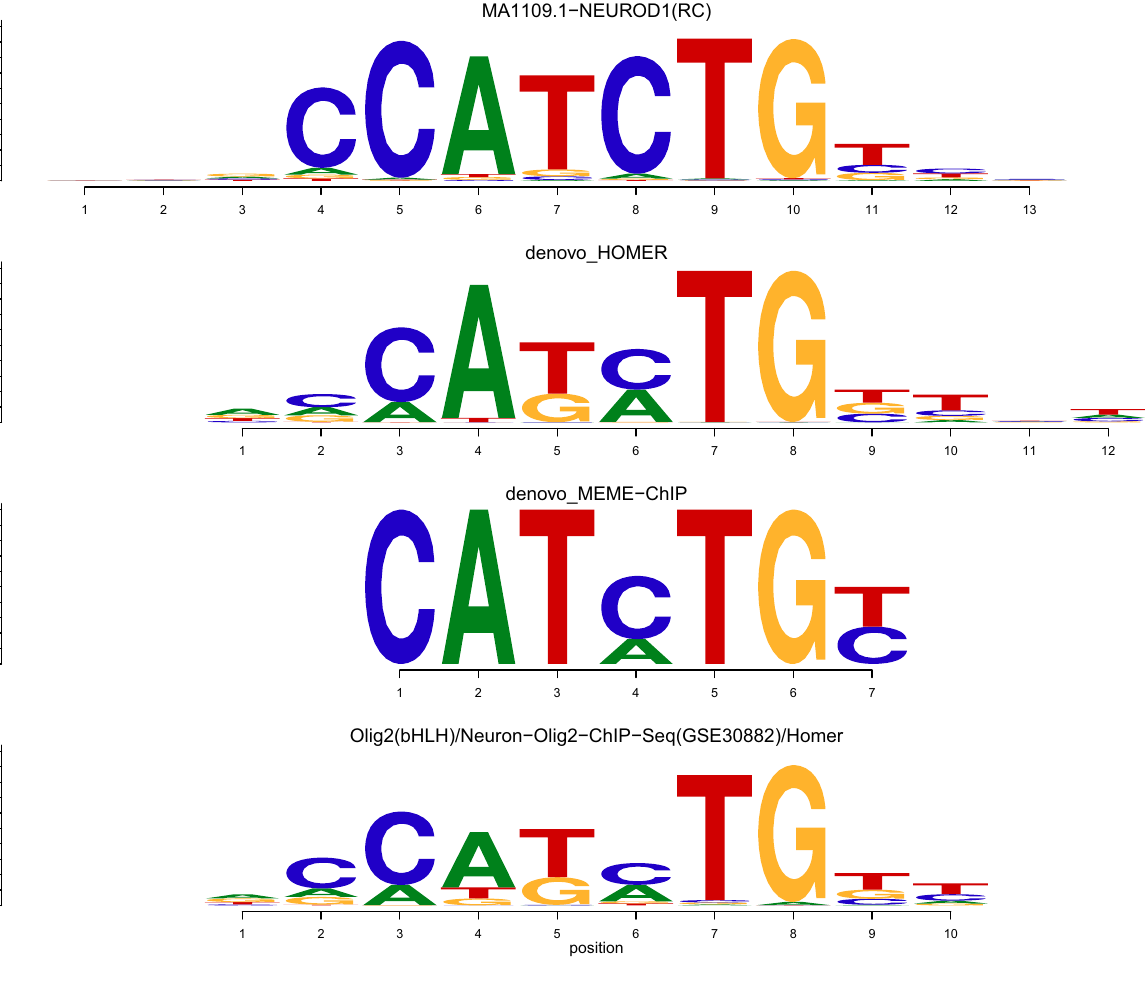
Figure 2. Comparison of de novo motifs matched to bHLH transcription factors. Denovo_HOMER is the de novo motif identified by HOMER, while denovo_MEME-ChIP refers to the de novo motif identified by MEME- ChIP. Olig2(bHLH)/Neuron-Olig2-ChIP-Seq (GSE30882)/Homer is the known motif best matched to denovo_ HOMER and is part of the HOMER Motif Database. MA1109.1-NEUROD1 is the known motif best matched to denovo_MEME-ChIP and is part of the JASPAR 2018 Core vertebrates non-redundant database. bHLH, Basic Helix-Loop-Helix; RC, Reverse